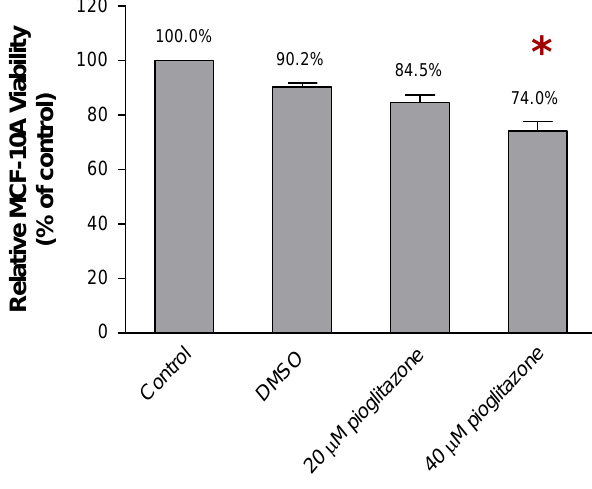
Figure 2. Viability of MCF-10A cells incubated with increasing concentrations of pioglitazone in the growth medium. One thousand cells were used as the input for incubation, and the incubation was carried out for 1 week. The values are expressed as mean ± SD from 3 replicates. * p < 0.05 was denoted as statistically